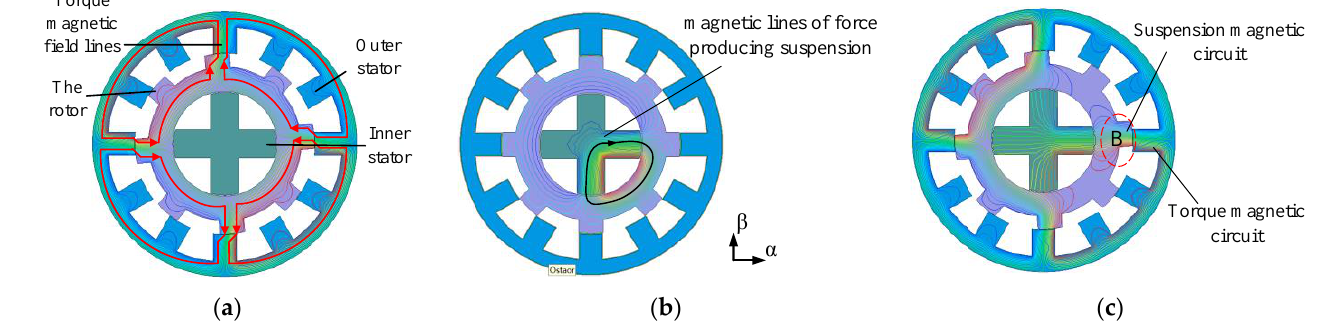
Figure 7. Double stator BSRM: ( a ) Phase A torque magnetic line of force; ( b ) +α and - β direction; and ( c ) Magnetic line of force of phase A torque winding and +α suspension winding.